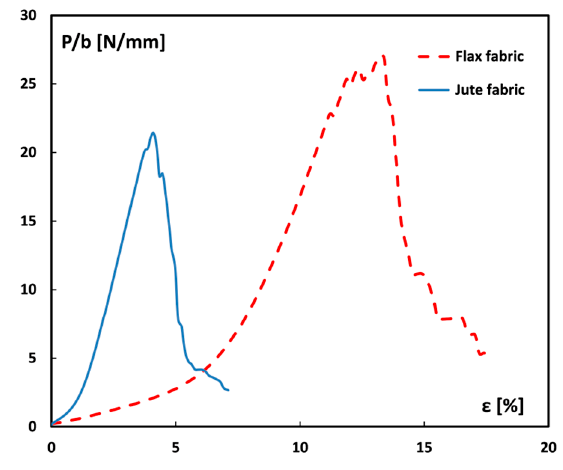
Figure 2. Stress-strain tensile curves of dry flax and jute fabrics.